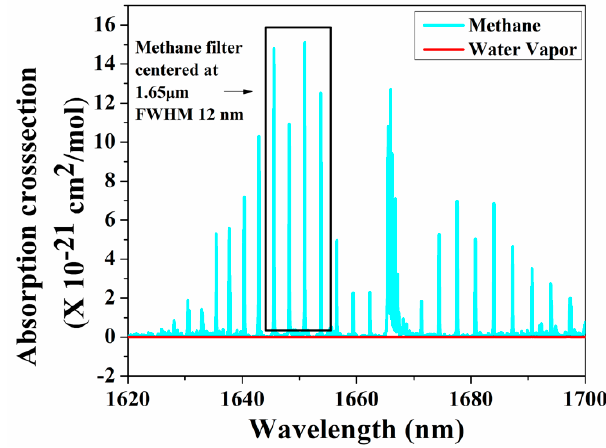
Figure 6. Broadband absorption spectra for methane.